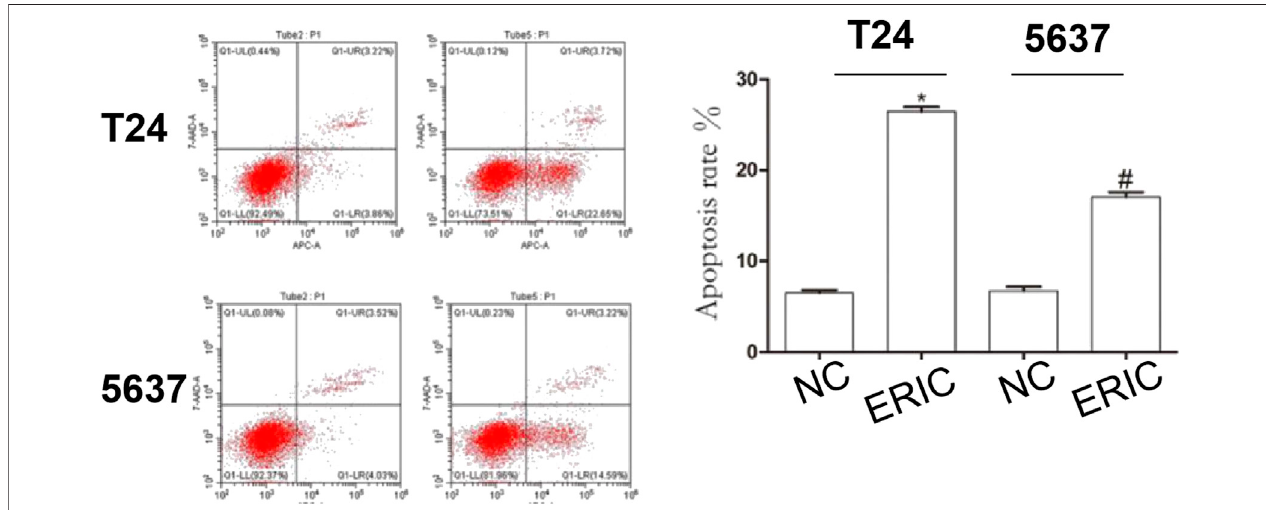
FIGURE 7 | Changes in apoptotic rate in each group. Cell apoptosis level was determined by fl ow cytometry. The mean value ± SD was shown. * p < 0.05. # p <